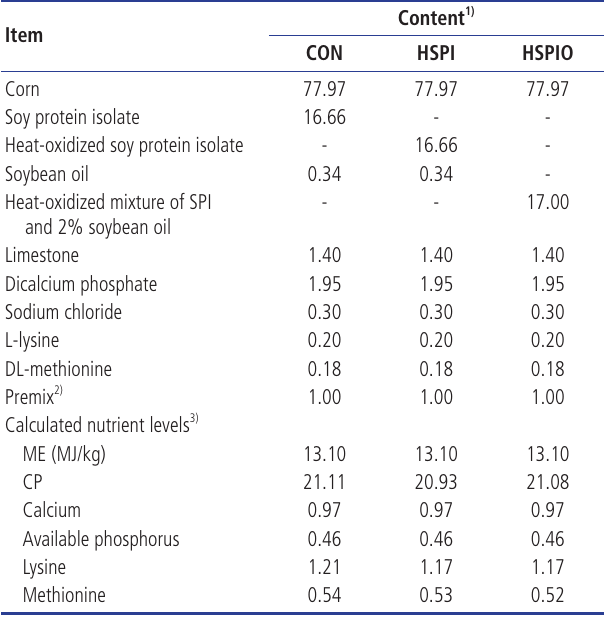
Table 1. Ingredient composition and nutrient levels of the experimental diets (%, air- dried basis)